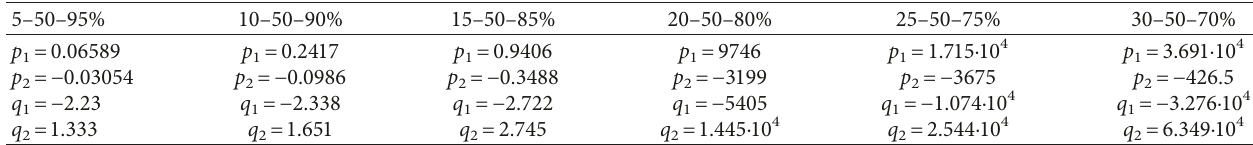
Table 8: Parameters { p i , q i } of the rational function f 2 ( α ) for the different sets of symmetrical